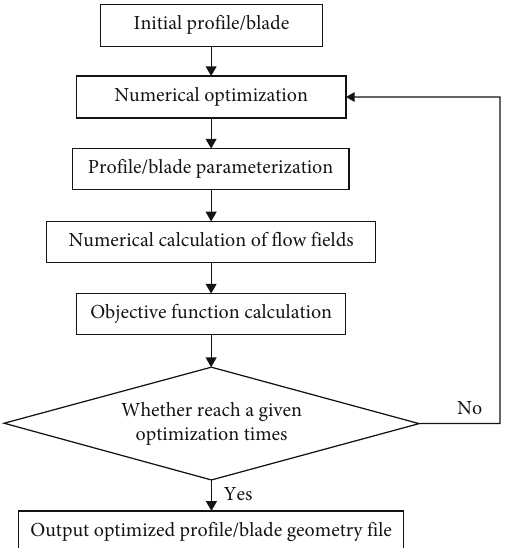
Figure 1: Automatic optimization design